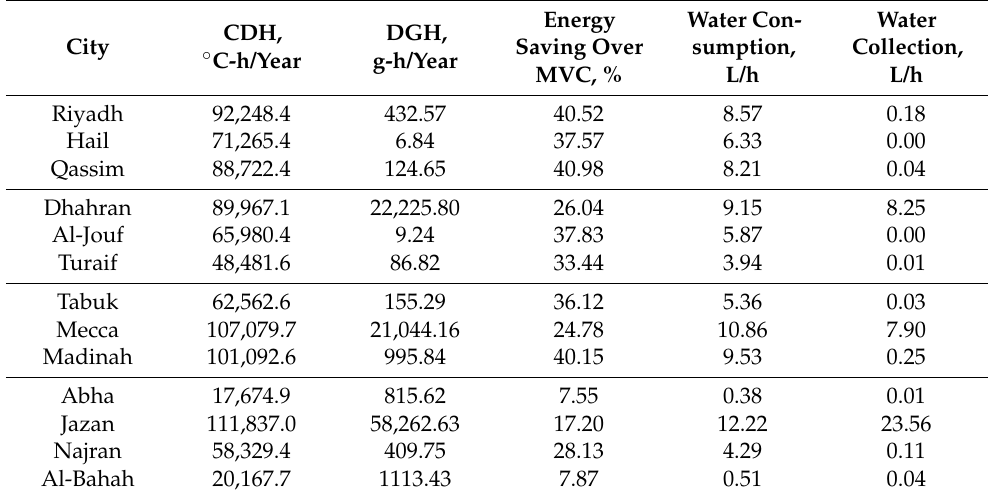
Figure 13. Hybrid IEC-MVC that collects condensate from MVC and reuses it in IEC. Reprinted with permission from Ref. [57]. Copyright 2014, MDPI. Table 1. Long-term performance of IEC-MVC for treating 1 kg/s of outdoor air. Adopted with permission from Ref. [54]. Copyright 2022,